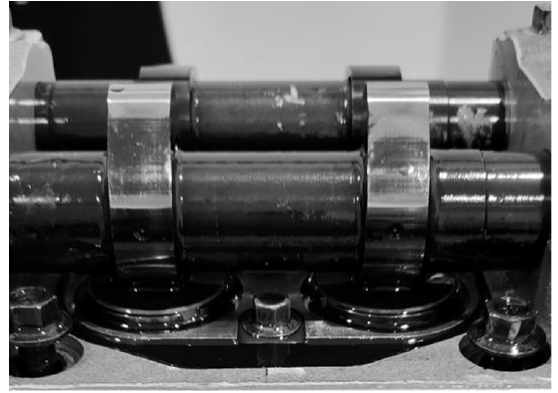
Figure 3. Contact state of the cam and shim. The total duration of the engine bench test is 1000 h, which is divided into three stages (350 h, 350 h, 300 h). Therefore, the wear time to each stage is 350 h, 700 h, and 1000 h. The worn surface morphologies were analyzed using optical microscopy (OM) and scanning electron microscopy (SEM). Several wear loss measurement methods are available. The amount of wear can be characterized by wear depth, wear area, wear volume, or weight loss. Among them, the method of weight difference is more convenient to measure. Other methods are not applicable to the shim because the boundary between worn and unworn areas is not very clear, and the measurement is easily inaccurate. Therefore, the weight loss of shim is measured after shutdown in each stage. The weight